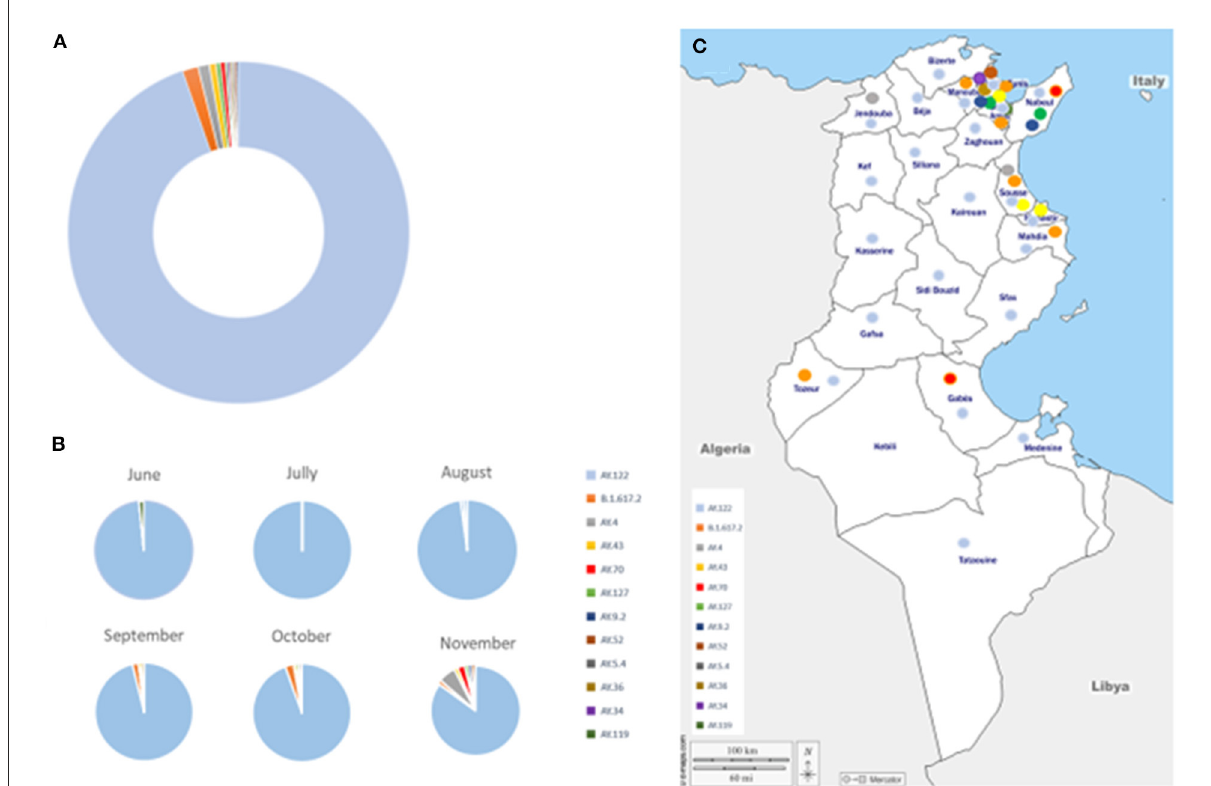
FIGURE3 Distribution of Delta sub-lineages, during the study period. (A) Global distribution. (B) Temporal distribution. (C) Geographic distribution of Delta sub-lineages, during the study period. Delta sub-lineages are indicated by colored circles, as indicated in the